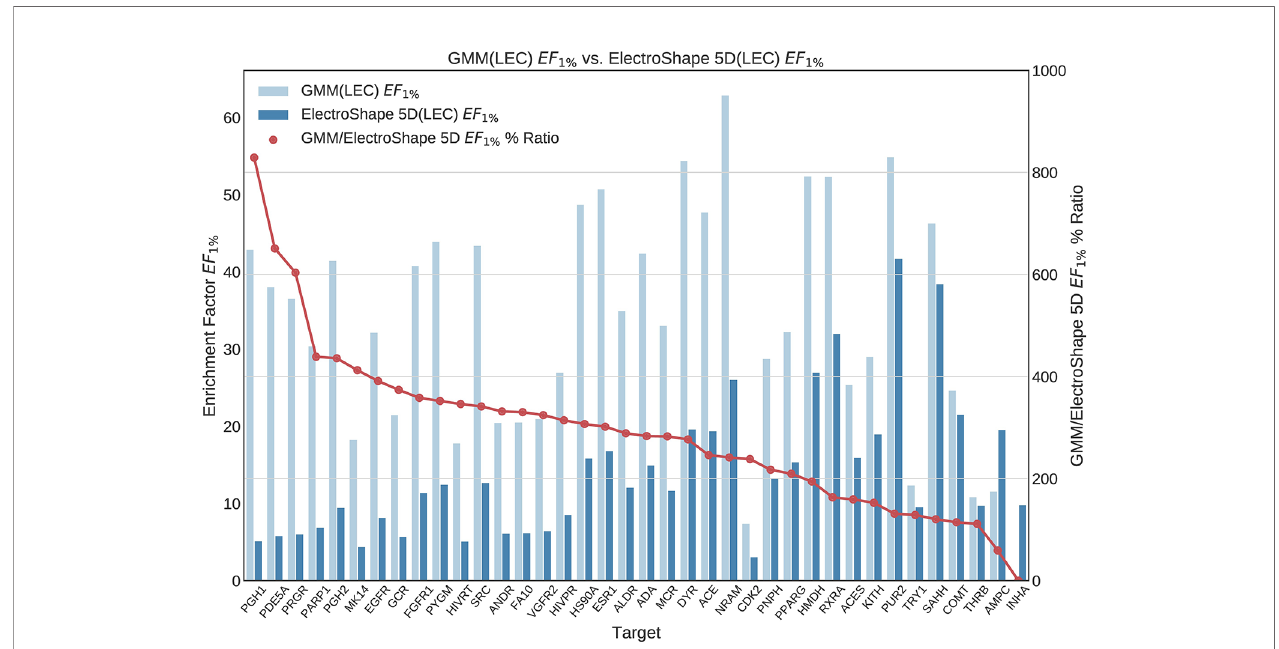
FIGURE 6 | Comparison of Enrichment Factor at 1% obtained by Gaussian Mixture Model with that obtained by ElectroShape 5D using Lowest Energy Conformers. Also plotted is the percentage ratio of the Enrichment Factor score of Gaussian Mixture Model (GMM) compared to ElectroShape 5D. Mean ratio = 291% ± 162%, max = 829%, min = 0%.